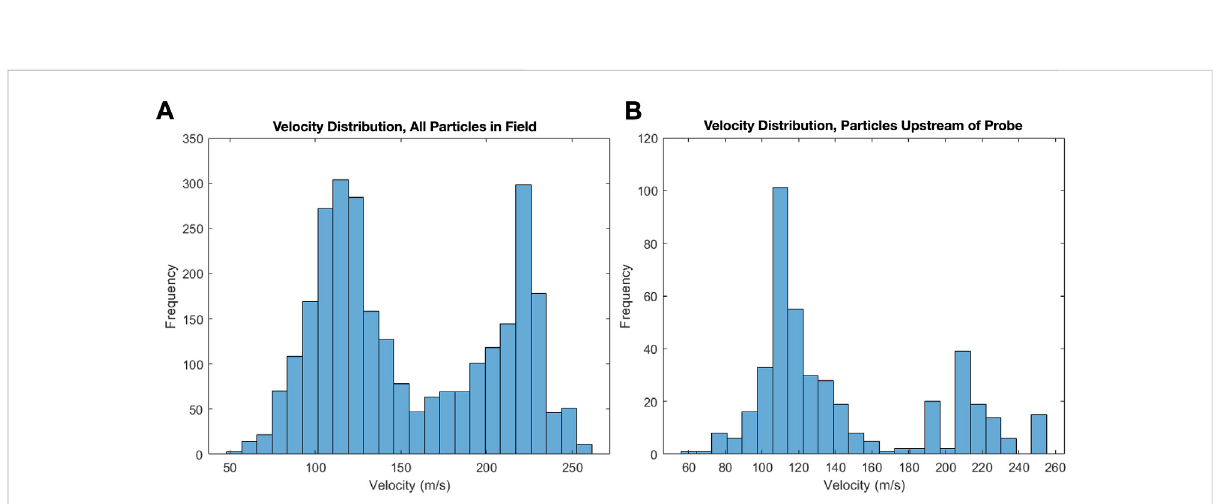
FIGURE 11 Particle velocity distribution pro fi les from PTV results for full fi eld (A) and for regions far upstream (1) and directly upstream (2) of sampling probe (B)